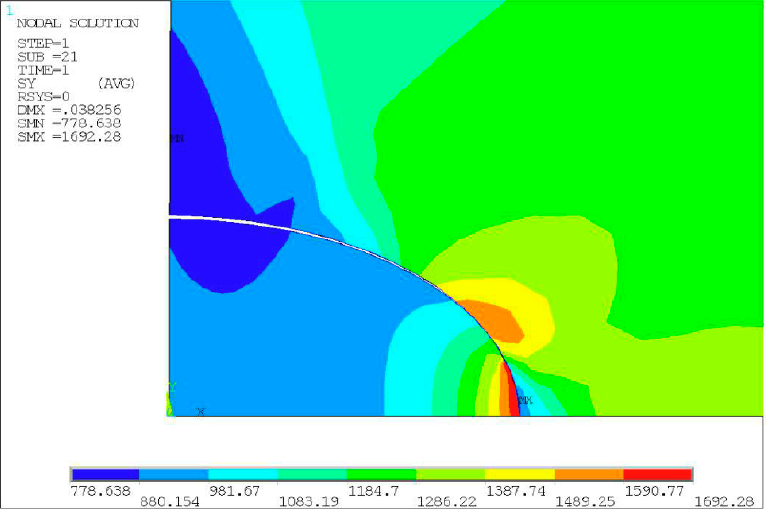
Figure 8. Stress cloud chart result of specimen No. 2.